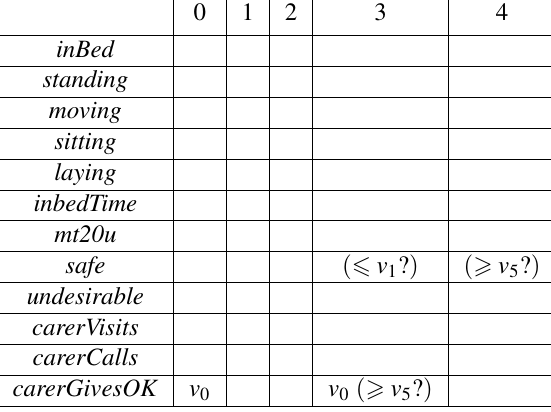
Table 7. The Searching Process of